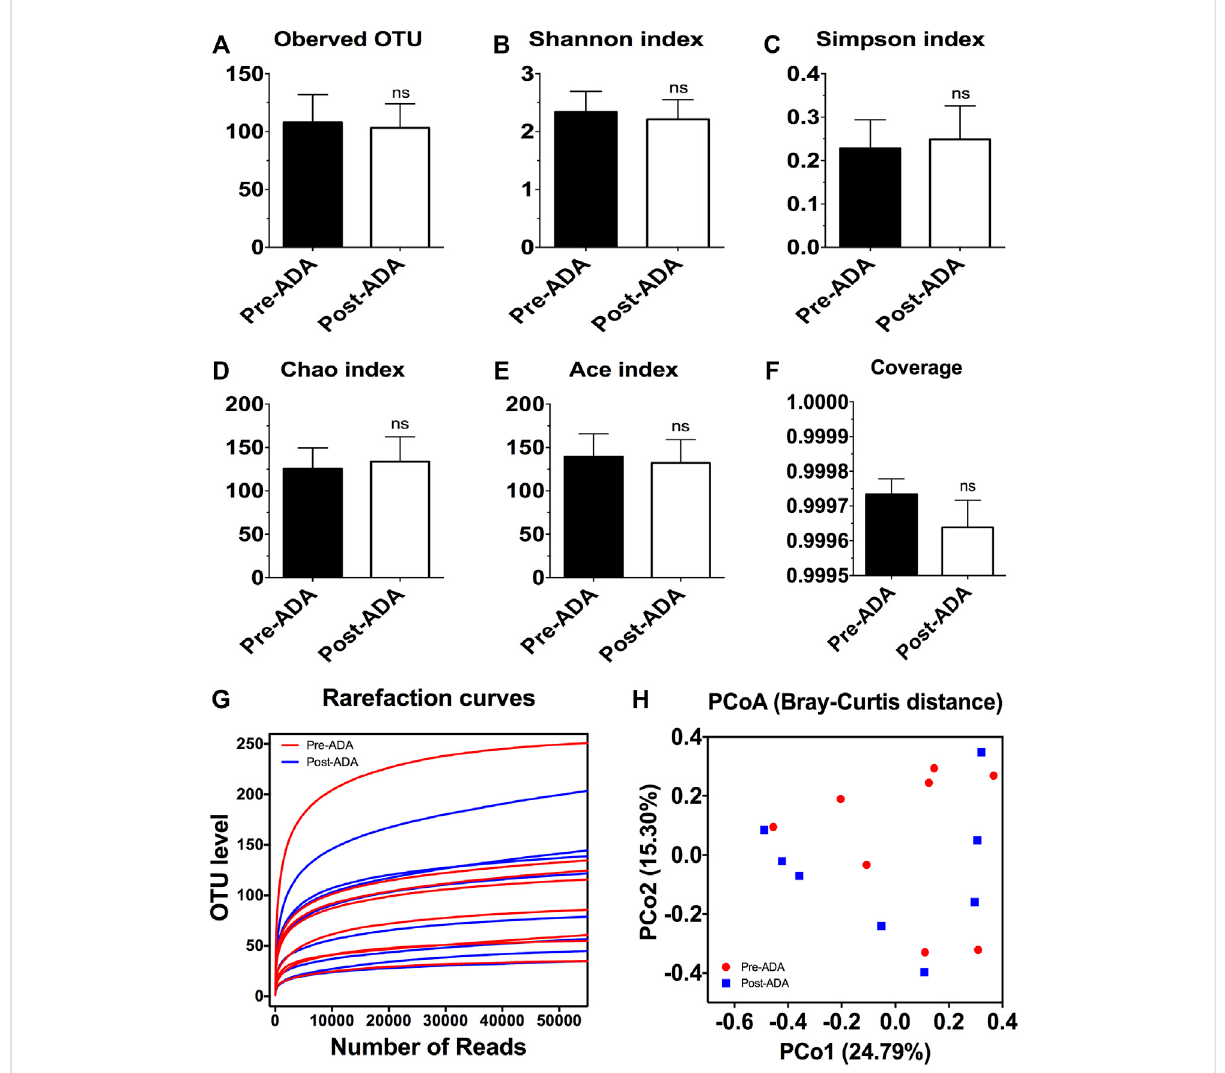
FIGURE 3 Thealphaandbetadiversityanalysisofgutmicrobiota inCDpatientsduringADAtherapy.Alphadiversityindicesasestimatedusingthenumber of observed OTU (A) , Shannon index (B) , Simpson index (C) , Chao index (D) , ACE index (E) , coverage (F) , and rarefaction curves (G) ; beta diversity of gut microbiota calculated via PCoA across all pre- and post-ADA samples using Bray – Curtis distance (H) ; ns, not signi fi